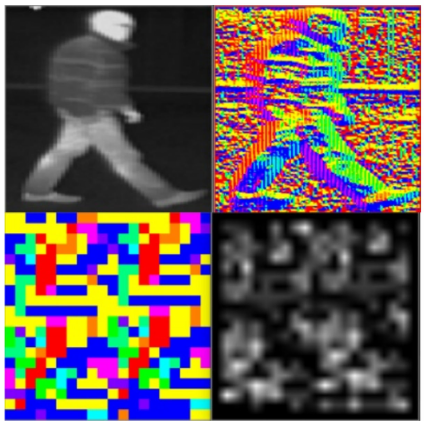
Figure 4. Top left image is the original image. The top right image represents the orientation of each pixel, which is represented using a different color. In the bottom left, the dominant orientation for each cell of 10 × 10 pixels is selected. In the bottom right image, the LBP representation of the orientation image is shown. Using the information from this LBP image, a uniform local binary pattern histogram is